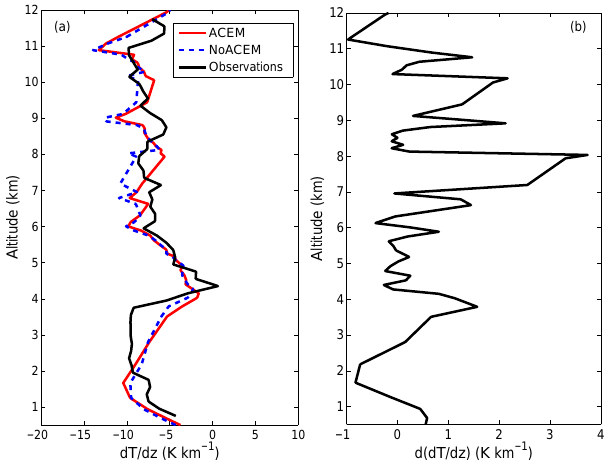
Figure 4. (a) Vertical profile of d T/ d z (Kkm − 1 ) over the bal- loon flight region on 17 March 2010 from (black line) observa- tions, (blue dashed line) simulations without BC emissions from aircraft (NoACEM) and (red line) simulations with BC emissions from aircraft (ACEM). (b) Vertical profile of difference in d T/ d z values for two model simulations; d ( d T/ d z) = ( d T/ d z ) ACEM − ( d T/ d z)